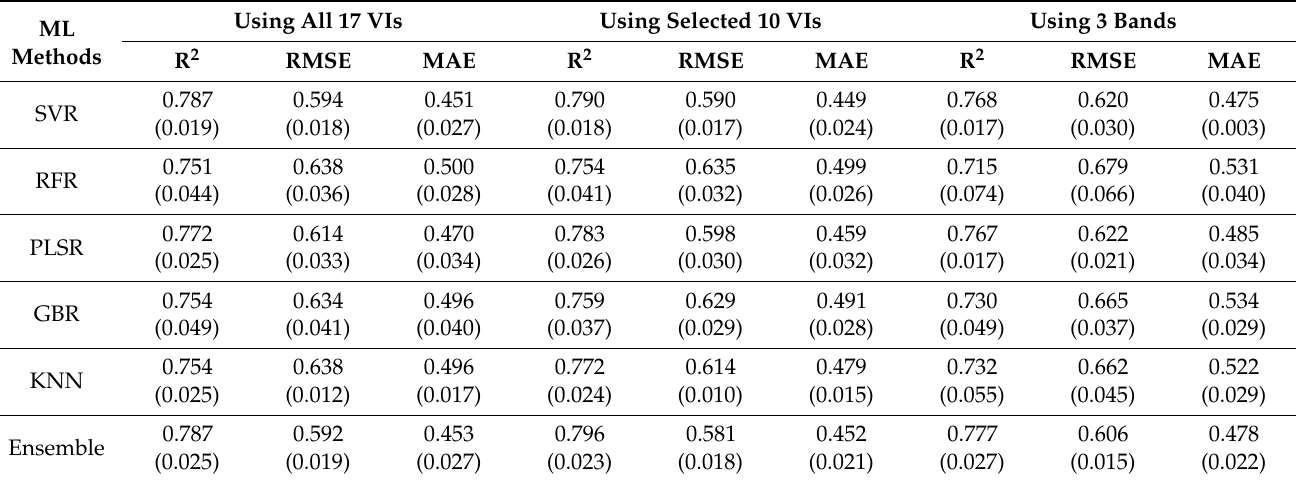
Table A2. Test accuracies including mean and standard deviation of five base models and an ensemble